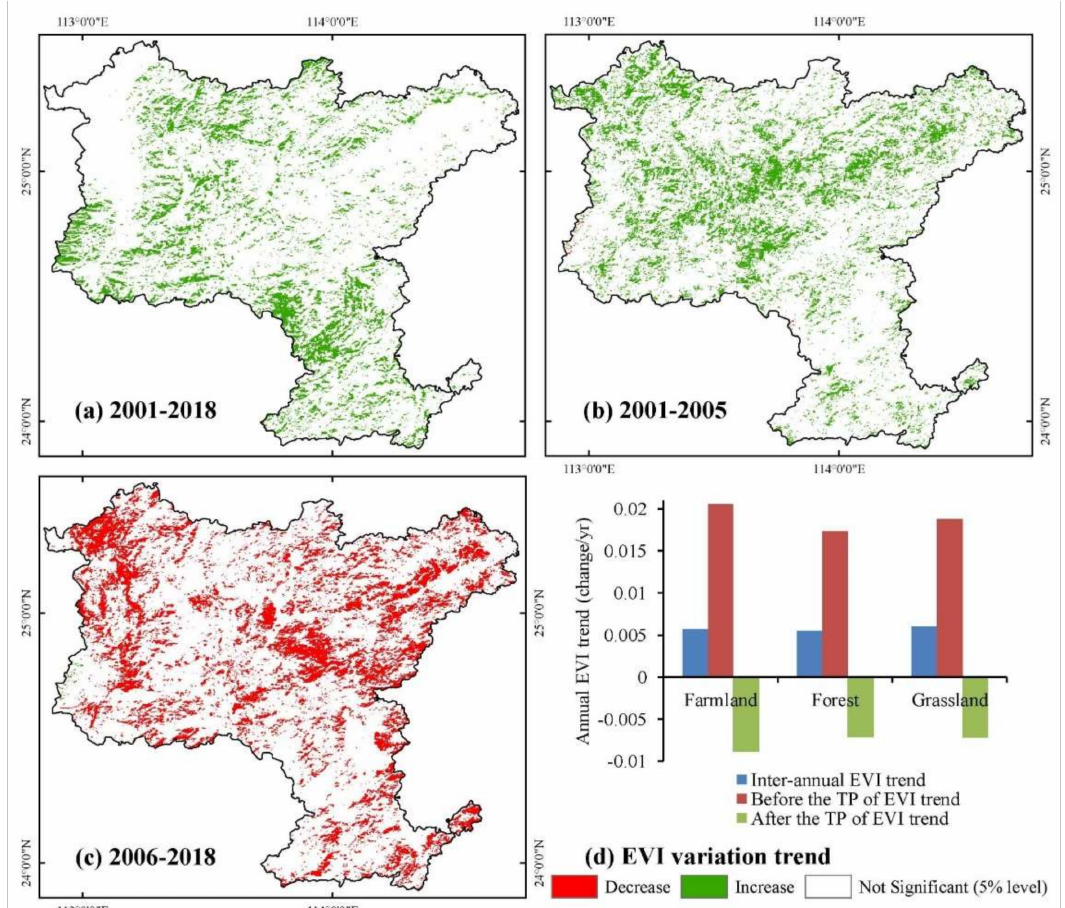
Figure 4. ( a – c ) Vegetation trend for different periods: ( a ) 2001–2018, ( b ) 2001–2005, and ( c ) 2006–2018) based on the annual mean EVI. ( d ) Vegetation trend in different periods for different land cover